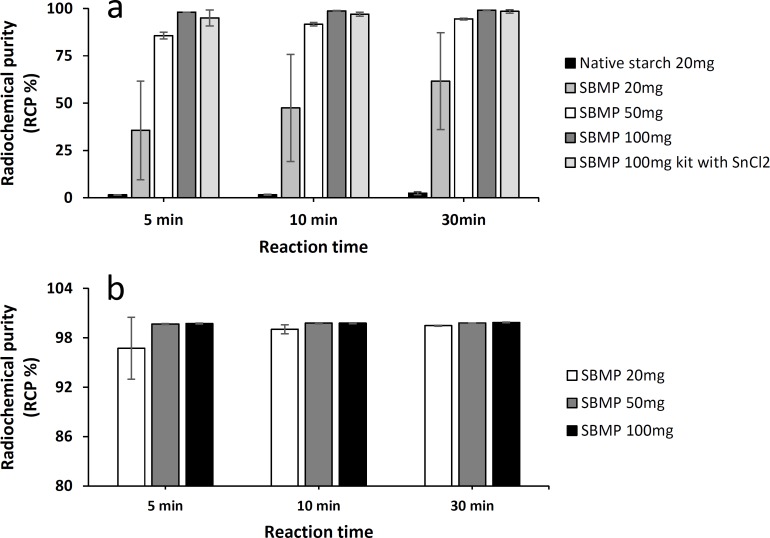
68Ga radiolabeling of SBMP.(a) Direct radiolabeling of varied amount of SBMP or native starch with 68GaCl3 eluate. (b) Optimization of 68Ga radiolabeling of varied amount of SBMP with addition of 0.5mL of sodium acetate trihydrate 1M (pH4.1).